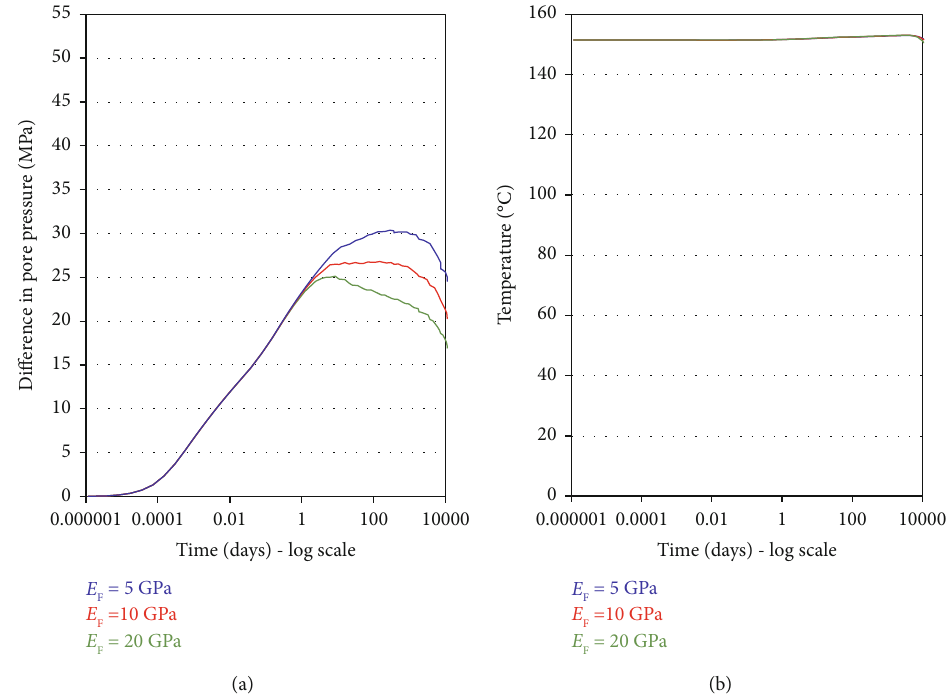
ff erence in the fl uid pore pressure between the Figure 12: E ff ect of the elastic modulus E F of the fracture zones on the time evolution of the di injection and production boreholes (a) and the temperature at the production borehole